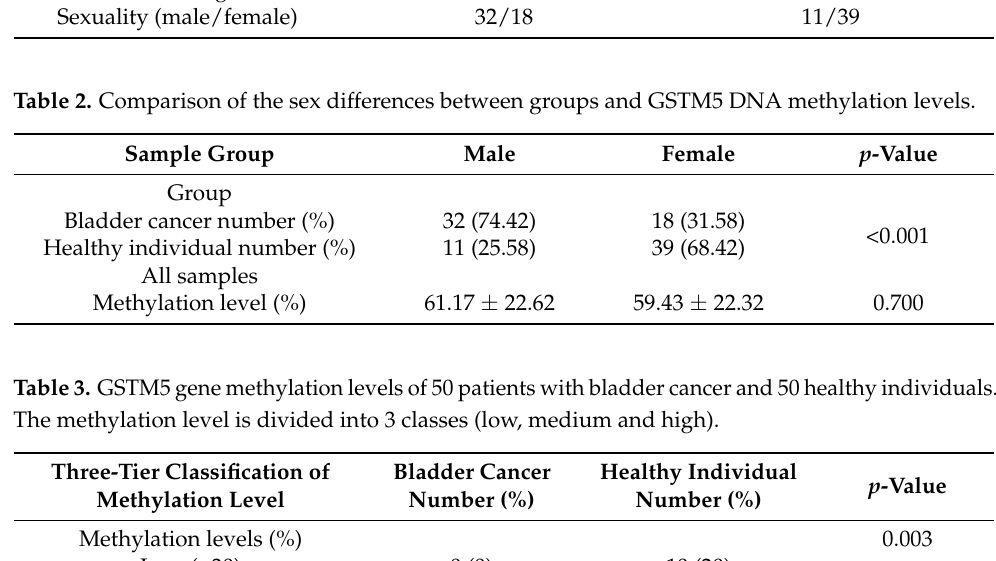
Table 1. The age and sex of 50 patients with bladder cancer and 50 healthy individuals.